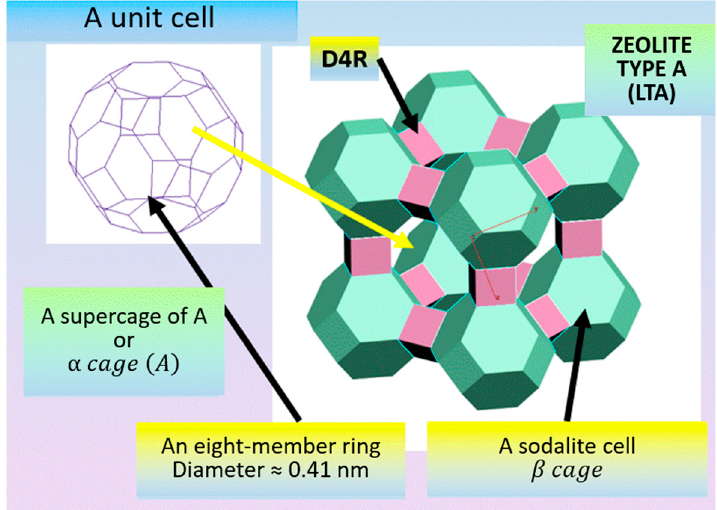
Figure 10. Type A sodalite unit cell [compiled by the authors]. Cubic units (paired quadruple rings), located at the midpoints of the unit cell